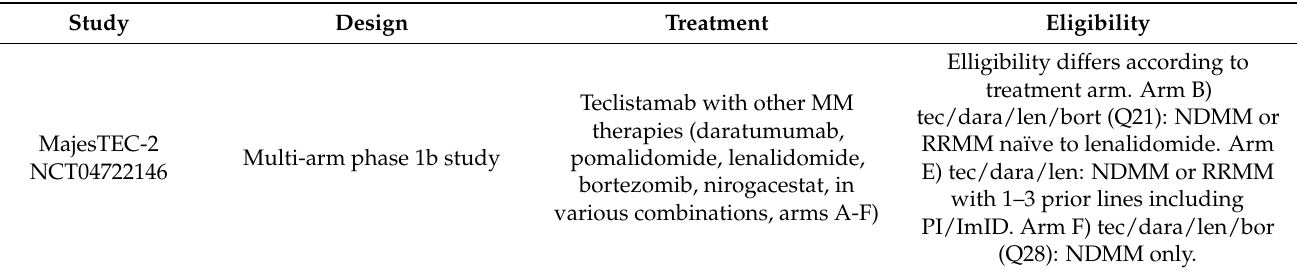
Table 3. Ongoing studies of BCMA-BsAbs in